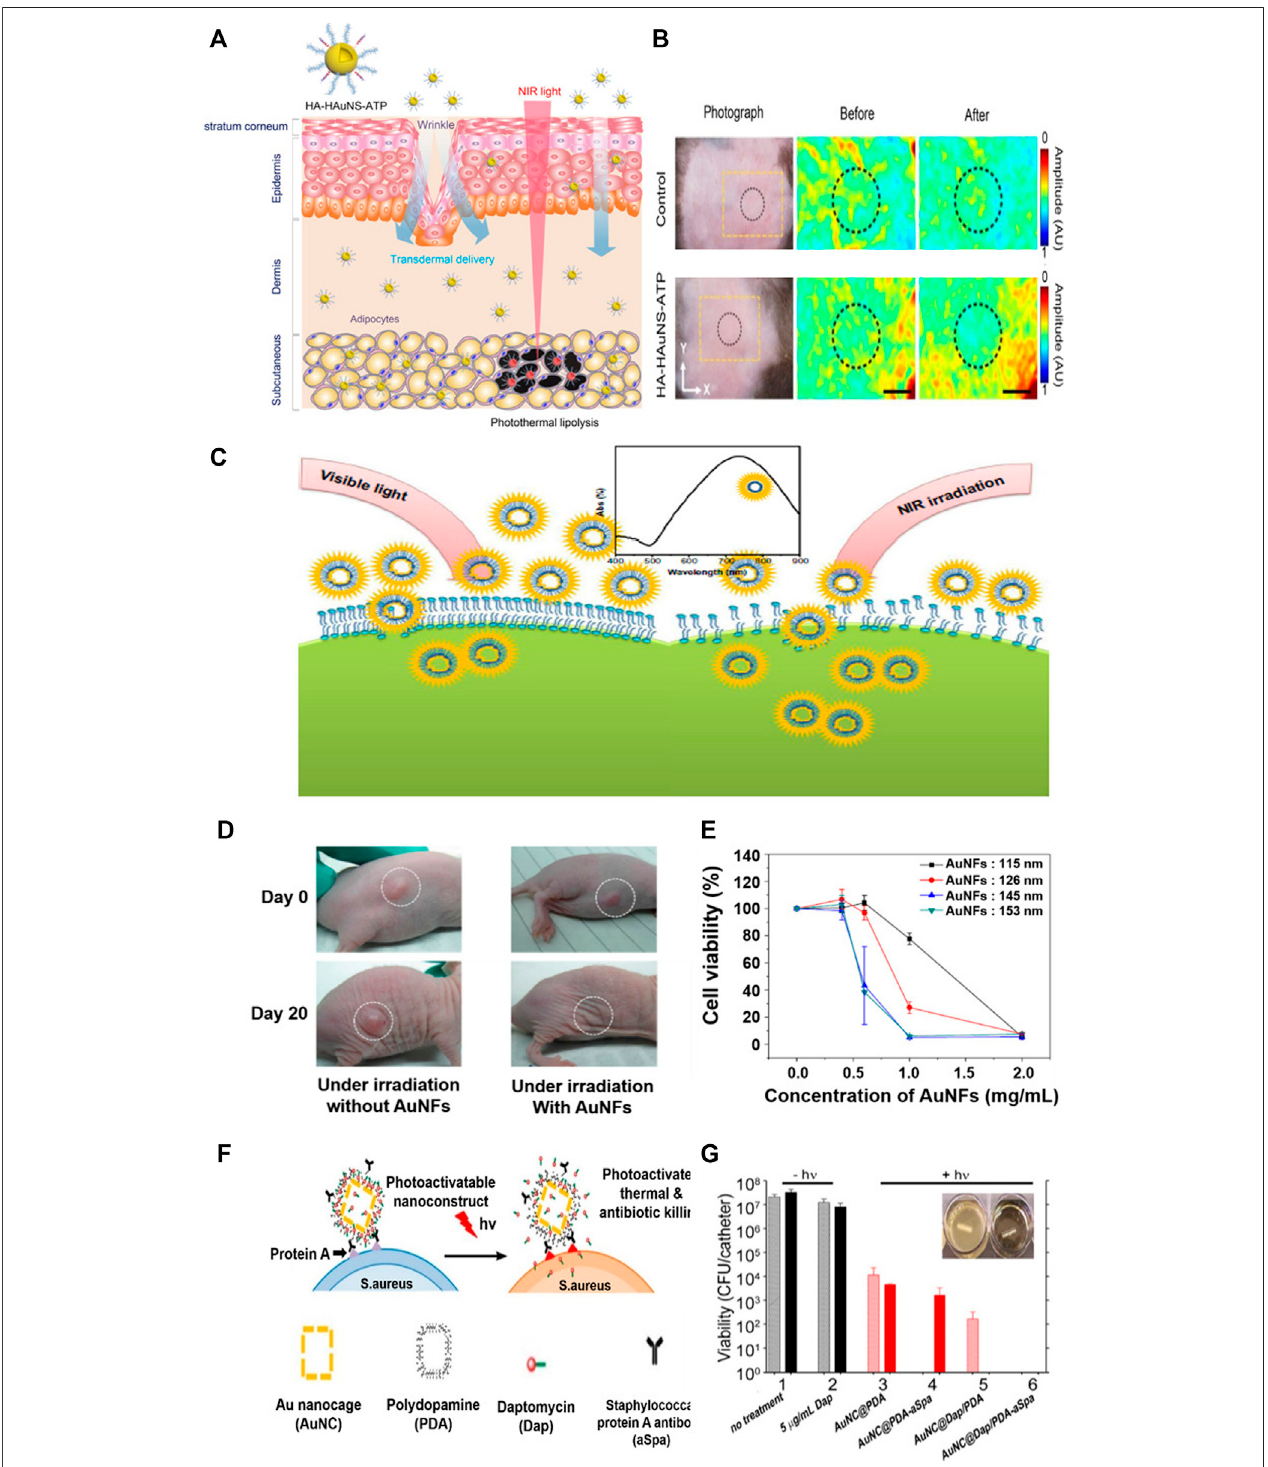
FIGURE 9 | Transdermal hyaluronic acid-hollow gold nanosphere-ATP conjugate for obesity treatment. (A) Schematic illustration of the targeted photothermal lipolysis of adipocytes after noninvasive transdermal delivery. (B) Photoacoustic images of subcutaneous adipose tissues before and after NIR lasers. Hollow gold nano fl owers with strong photothermal effects in near-infrared (NIR) areas. (C) Schematic representation showing the photothermal effect of the gold nano fl owers (AuNFs) on endocytosis under NIR irradiation. (D) Photothermal effect on a nude mouse under NIR irradiation caused by the addition of gold nano fl owers. (E) RelationshipbetweenHeLacellviabilitiesand theconcentrationofgoldnano fl owerswithlaserirradiation( λ (cid:1) 808 nm,9 W/cm 2 ,5 min).Goldnanocages(AuNC) loaded